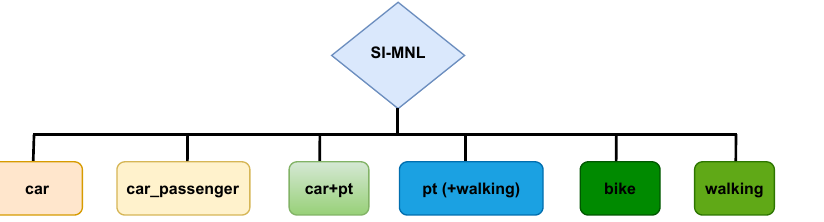
Figure 4. Structure of the MNL for modal choice estimation, considering the inter-modal